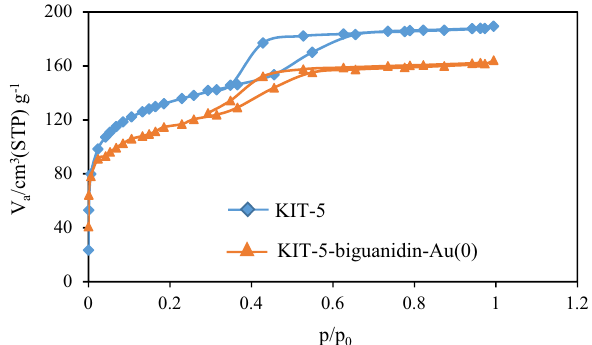
Figure 2. The N 2 adsorption–desorption pattern of the KIT-5 and KIT-5-biguanidine-Au (0) nanocomposite.